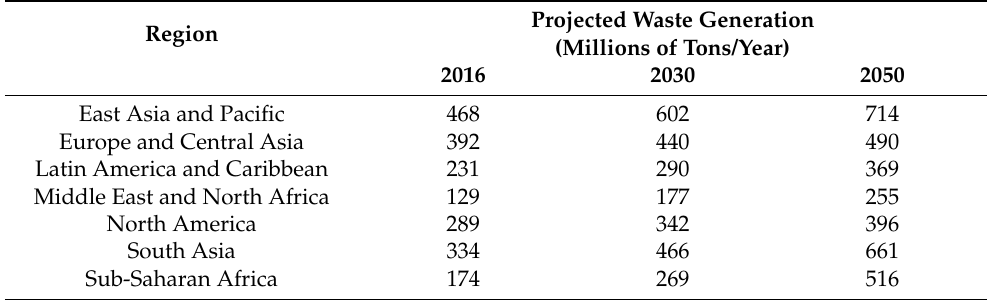
Table 1. Global waste generation